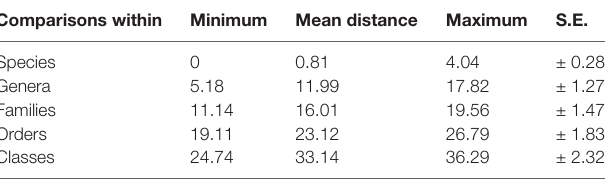
TABLE 2 | Summary of pairwise mitochondrial cytochrome c oxidase I (COI) barcode nucleotide divergences within various taxonomic levels, using K2P distances (%).